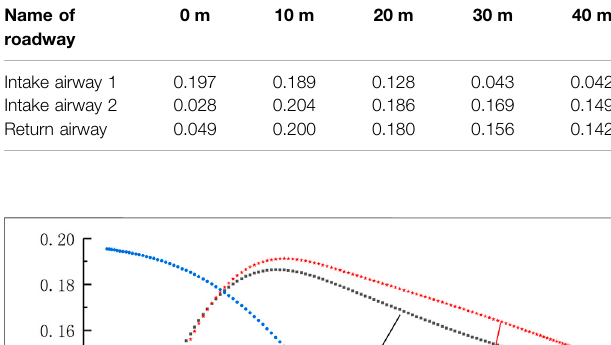
FIGURE 7 | Variation rule of overpressure peak value with distance in working face.